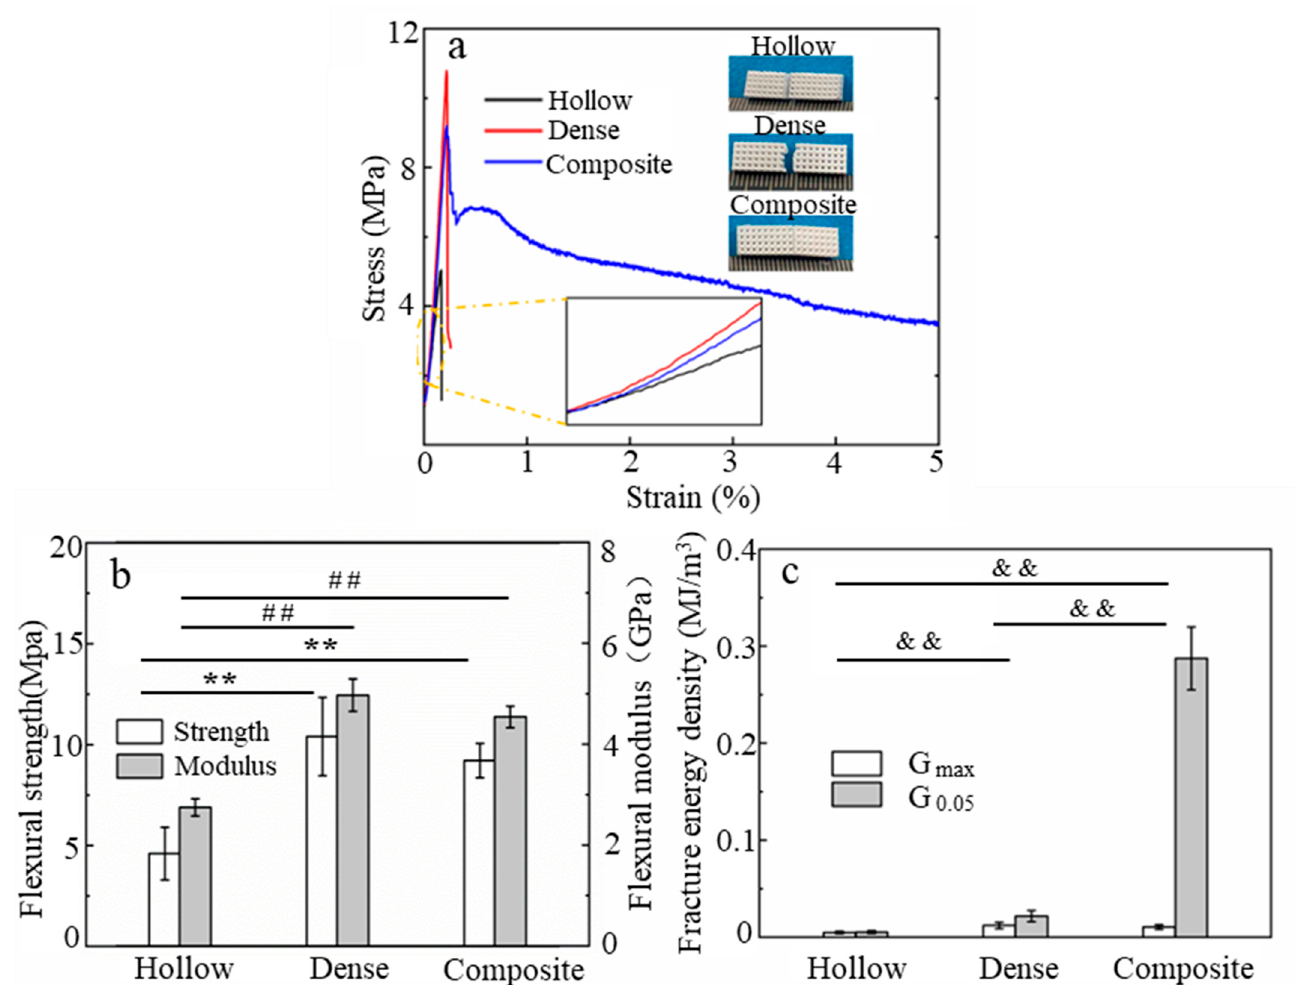
Figure 8. ( a ) Representative three-point bending stress-strain curves ( b ) flexural strength ( c ) fracture energy density for the different scaffolds. (Data presented are the mean ± standard error of the mean, n = 5, ** ## && p < 0.01) .